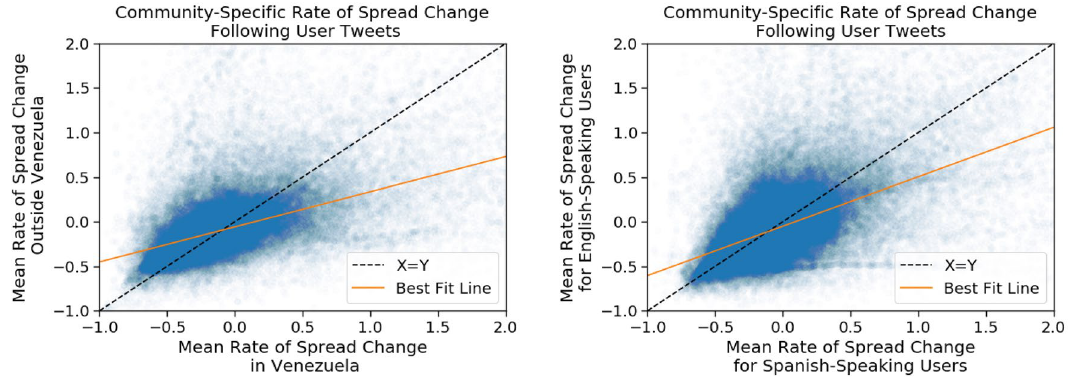
Figure 7. Relationship between the change in rate of spread within each pair of communities. (Left) Comparison of the change in spread rate induced by each user in the outside- versus inside-Venezuela community. (Right) Comparison of the change in spread rate induced by each user in the English- versus Spanish-speaking community. The best fit lines shown are determined using Huber regression and the fits are significant with p < 0.001 .